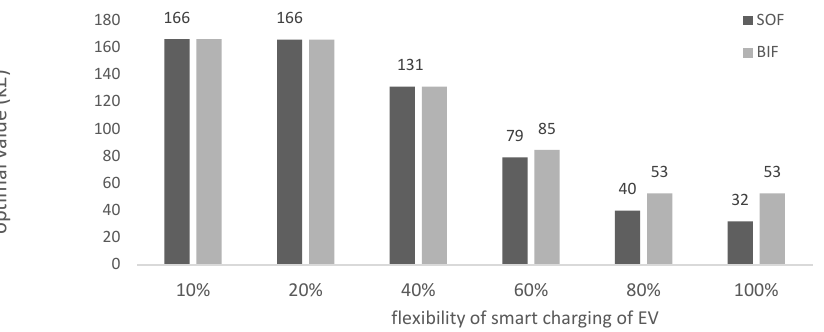
Figure 15. Optimal total expected system cost as a function of smart charging flexibility, under SOF and BIF.